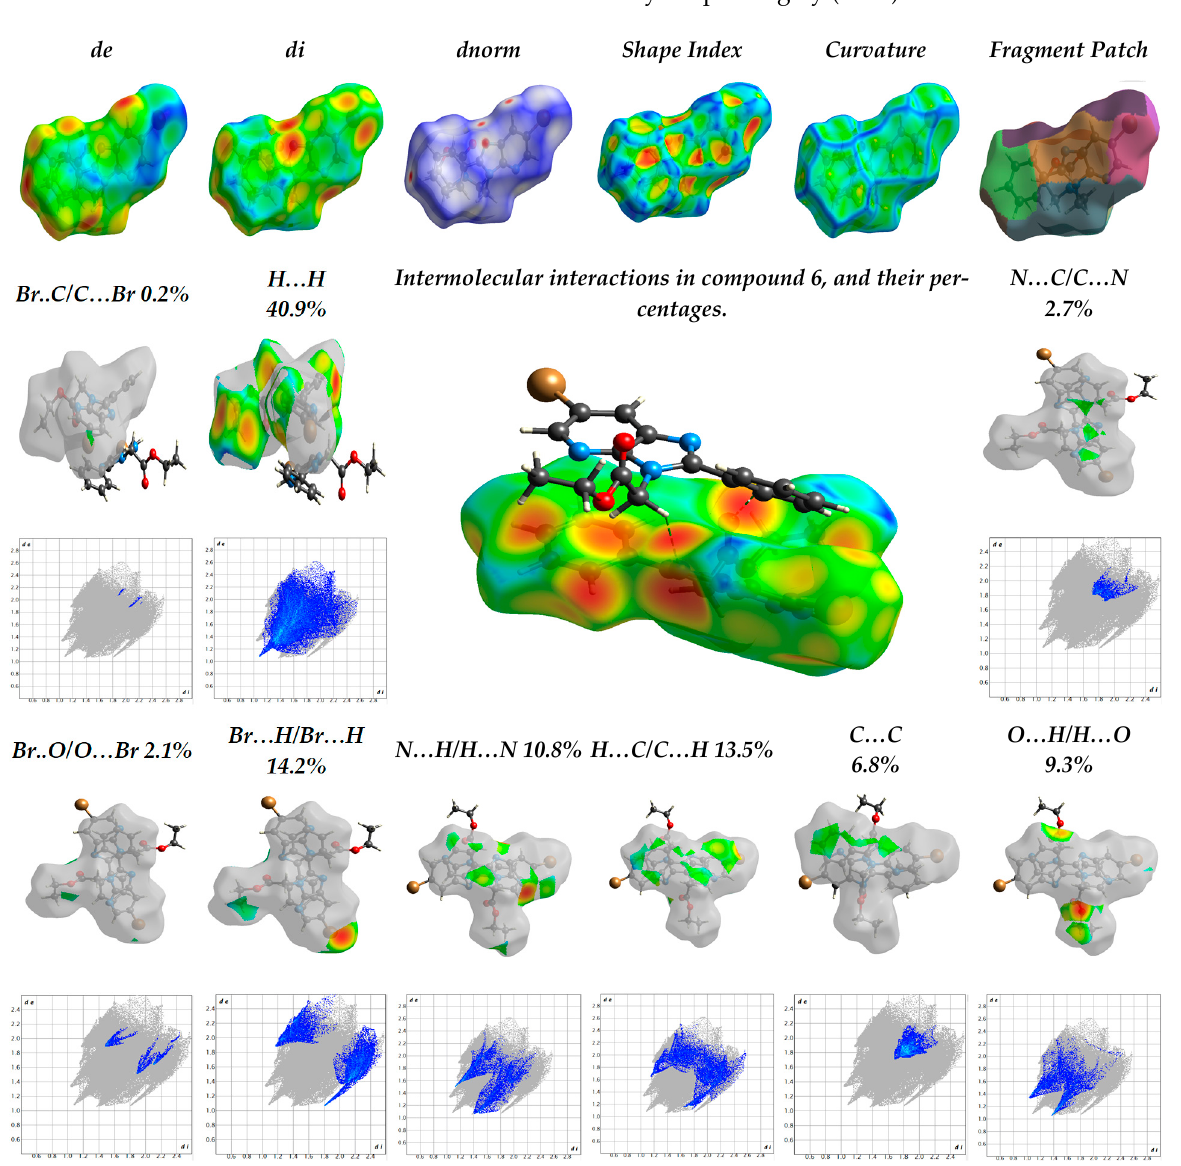
Figure 4. The HFM 2D interaction diagrams and their contribution to compound 6, as represented in the d norm , d i , d e , shape index “si”, curvedness “crv” and fragment batch “ fb ”. Compound 8 in (Figure 5) included (0.166 Å to 1.4059 Å) for dnorm , di (0.9196 Å to 2.637 Å) for di , (0.9176 Å to 2.5592 Å) for de , ( − 1.00 Å to 1.00 Å) for shape-index, ( − 4.00 Å to 4.00 Å) for curvedness and (0.00 Å − 15.00 Å) for patch fragment, respectively. The shortest interactions were for Br ••• C/C ••• Br (2.6%) and N ••• C/C ••• N (1.6%). The Hydrogen contacts as red zone, which were represented in dnorm fingerprint, had interactions